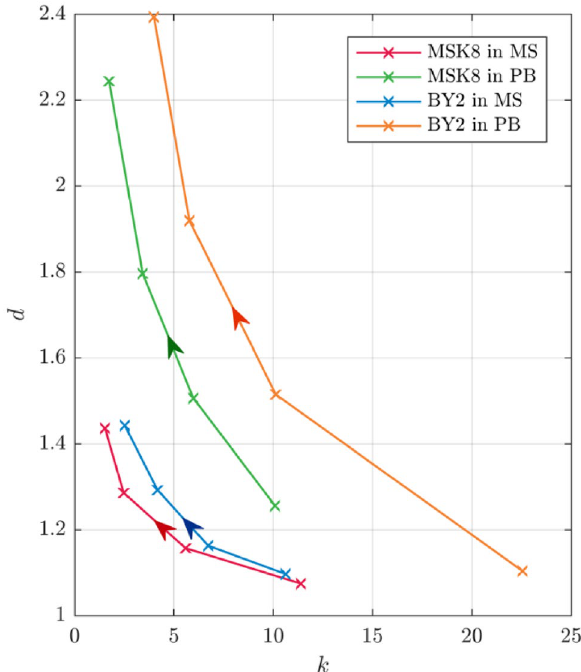
Figure 4. The relationship between d and k for various cell concentrations in both media for both cell types, with the arrows indicating increasing cell